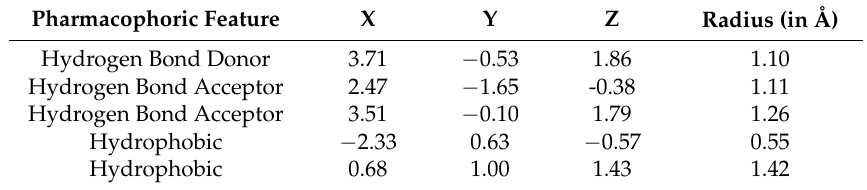
Table 10. 3D Coordinates and pharmacophoric features of the best-ranked pharmacophoric